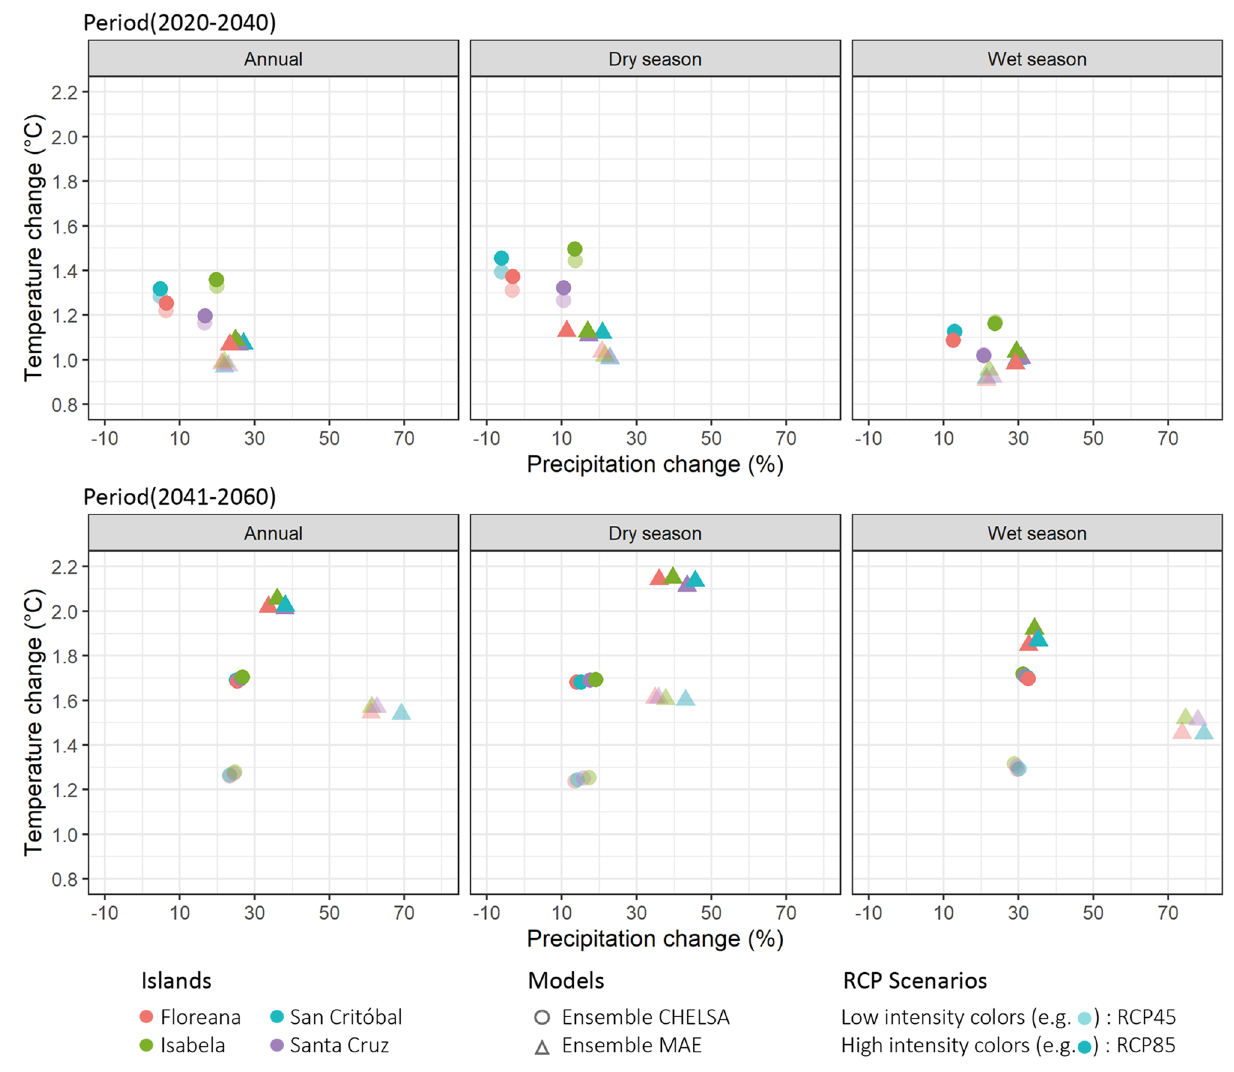
Figure 3. Summary of climate projections for projected average temperature and precipitation changes relative to the historic baseline as simulated by the MAE and CHELSA modelling efforts. Temperature on the y-axis represents absolute change in temperature. The x-axis represents percentual changes in precipitation. Circles represent outputs from the CHELSA modelling projections used here, and triangles represent those from the MAE experiments. The saturation of colors determines the RCP climate scenario; low color intensities represent RCP4.5, while high color intensities represent